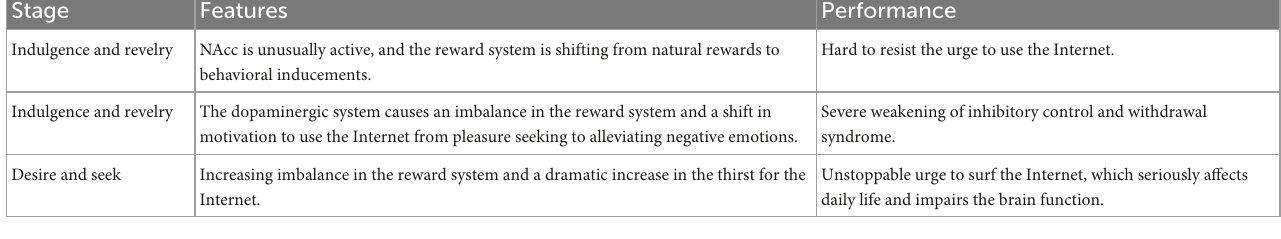
TABLE 1 Formation process of Internet addiction (IA) in the Availability, Controllability, Excitability (ACE) model (Kimberly S. Young). Stage